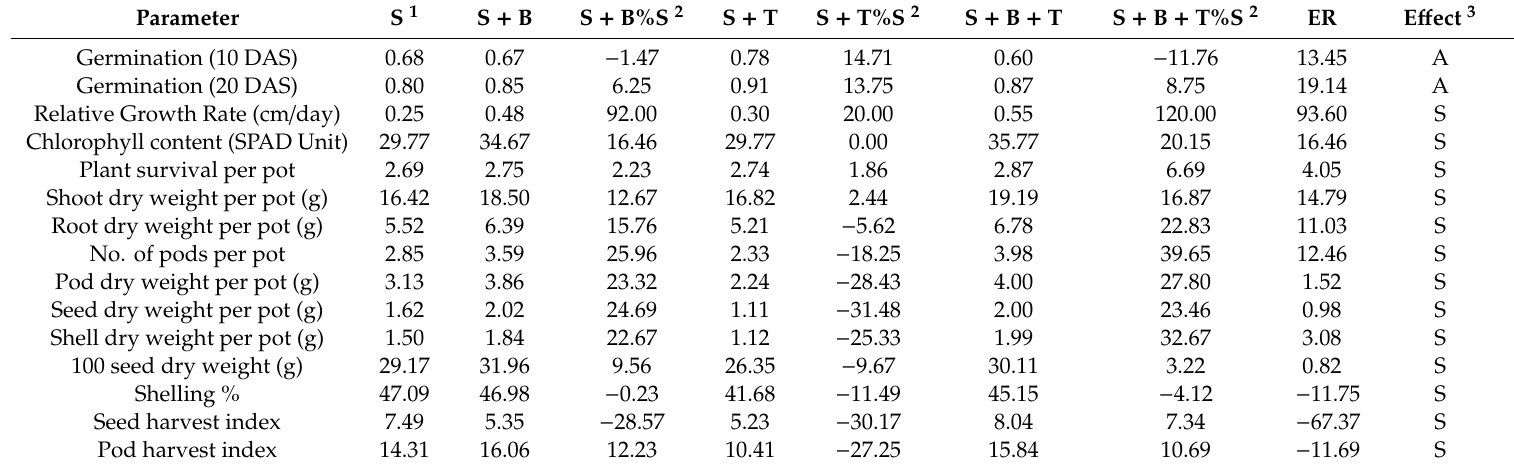
Table 6. Interactive e ff ects of Bradyrhizobium and Trichoderma on growth, development, and yield of